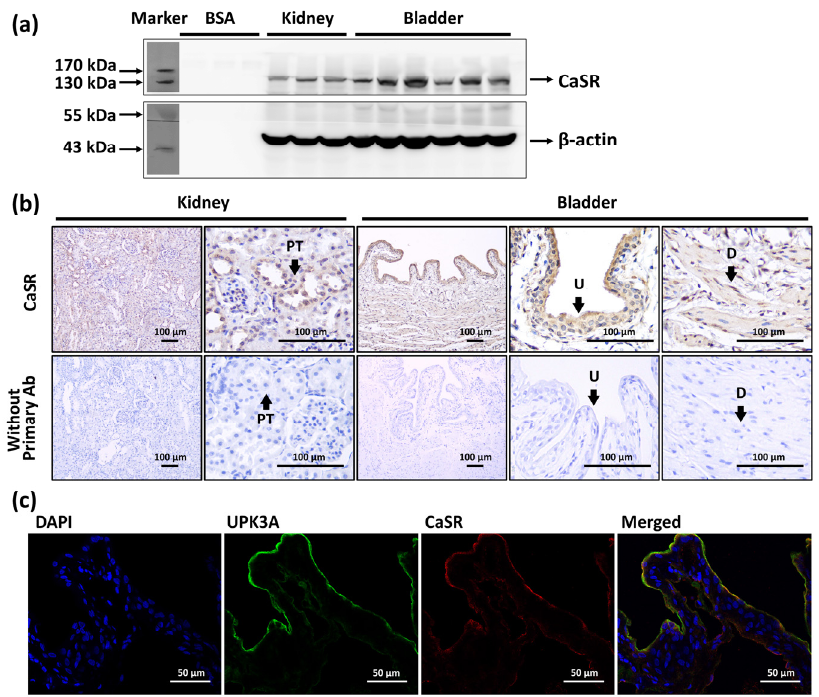
Figure 1. The expression and location of calcium-sensing receptor (CaSR) in bladder. ( a ) Western blot analysis of CaSR (MW: 130 kDa) in the whole kidney and whole urinary bladder. ( b ) Immunohistochemistry staining of CaSR (brown signals) in the urothelium (U) and detrusor (D) of bladder, and in the proximal tubule (PT) of kidney, and the staining without applying primary antibody (Ab). ( c ) Immunofluorescence staining of CaSR (red), uroplakin III A (UPK3A) (green), and DAPI (blue) in urothelium of urinary bladder.